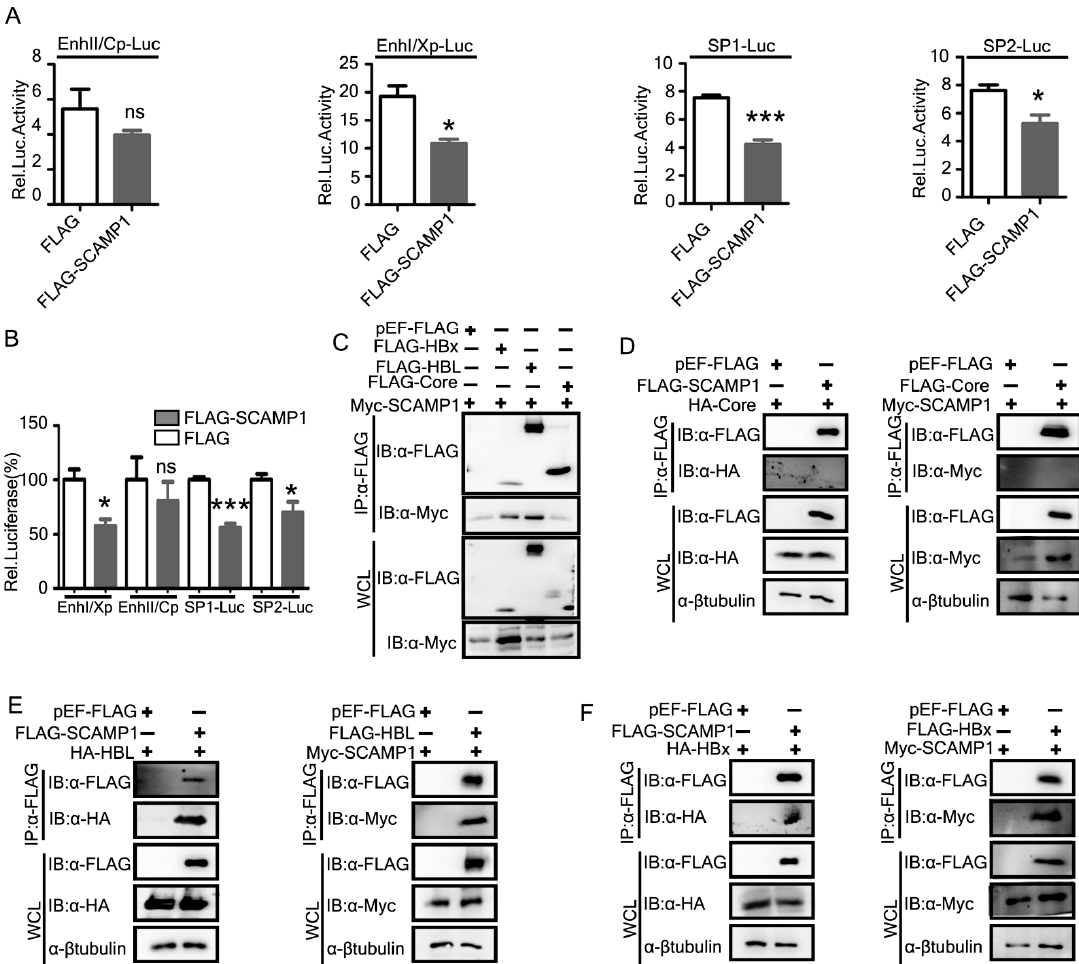
Figure 8. SCAMP1 reduces the HBV RNAs via transcriptional regulations. ( A , B ) HepG2 cells were co-transfected with four reporter plasmids individually and SCAMP1 expression plasmid or its con- trol vector. The cells were lysed 48 h post-transfection and subjected to luciferase activities assay. For each transfection, pRL-TK was included as a control for transfection efficiencies. The activity of EnhI/Xp, SP1, and SP2 was suppressed by SCAMP1. ( C – F ) Co-immunoprecipitation and immunob- lot analysis of Huh7 cells transfected with constructs expressing Myc-SCAMP1, HA-tagged HBV Core, X, L, or FLAG-tagged HBV Core, X, L, or pEF-FLAG, respectively are shown, (0.01 * p < 0.05; *** p < 0.001 and ns, not significant).